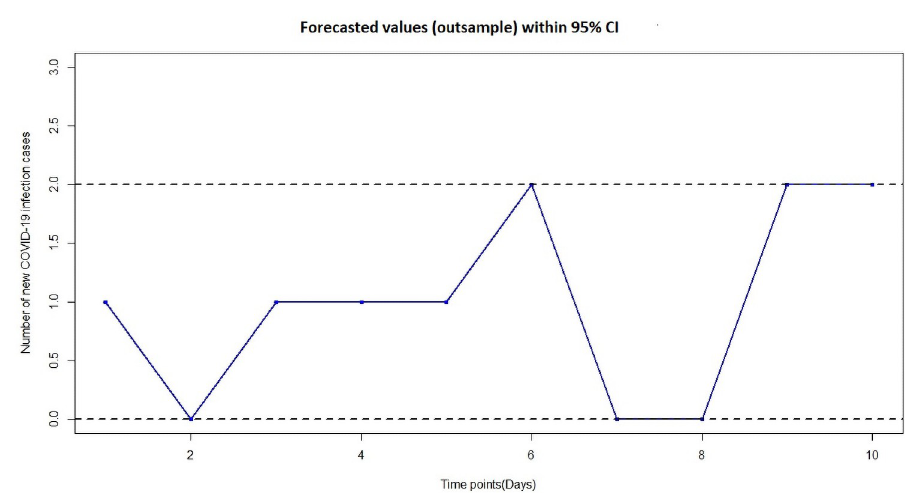
Fig 5. Forecasted values (out-sample) with 95% confidence interval.